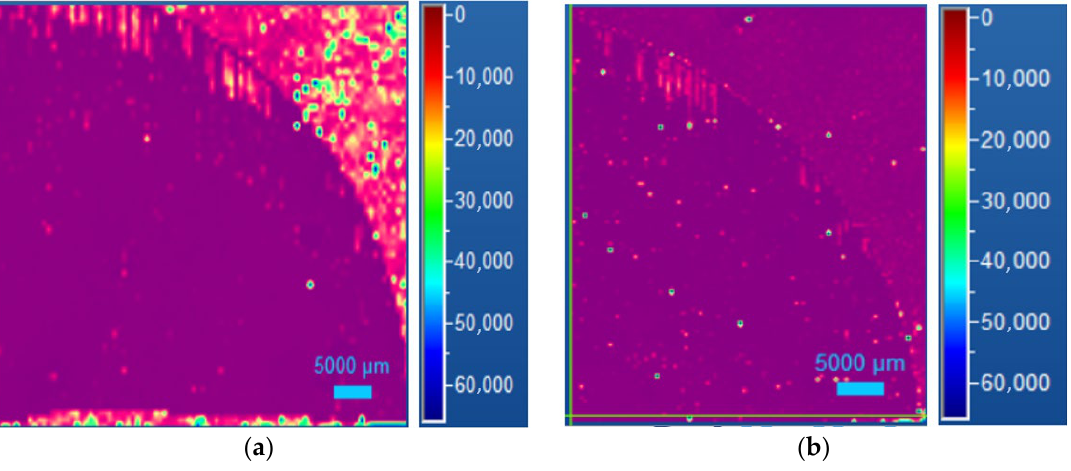
Figure 5. Photoluminescence map of the same quarter of the 4H SiC wafer highlighted in Figure 1a, before ( a ) and after ( b ) oxidation